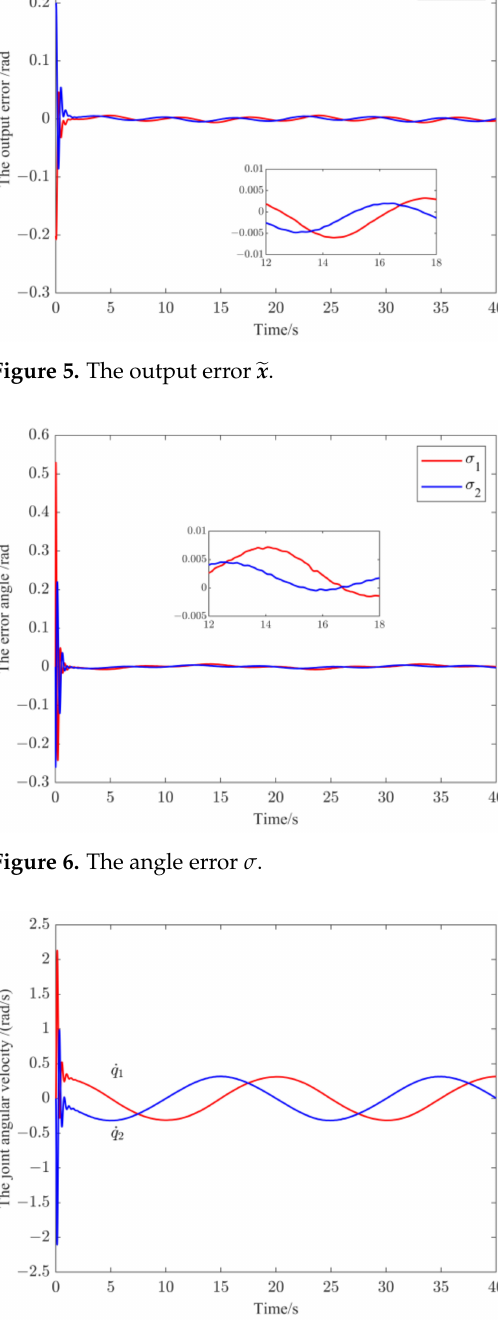
Figure 7. The joint angular velocity